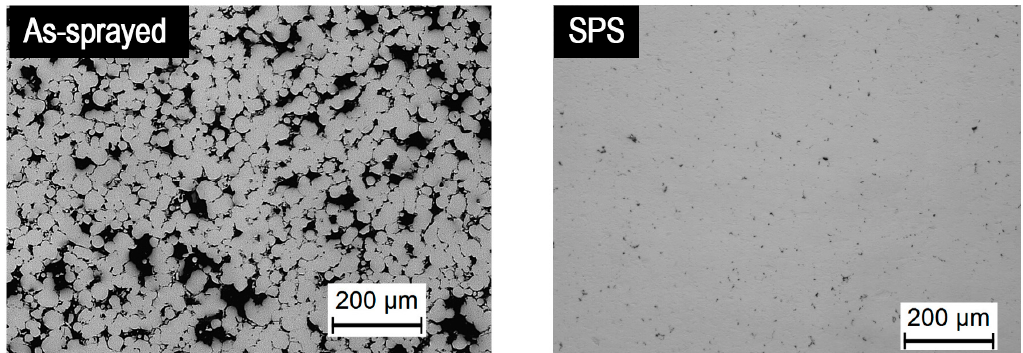
Figure 9. SPS effect on CSAM-ed Ti6Al4V microstructure.